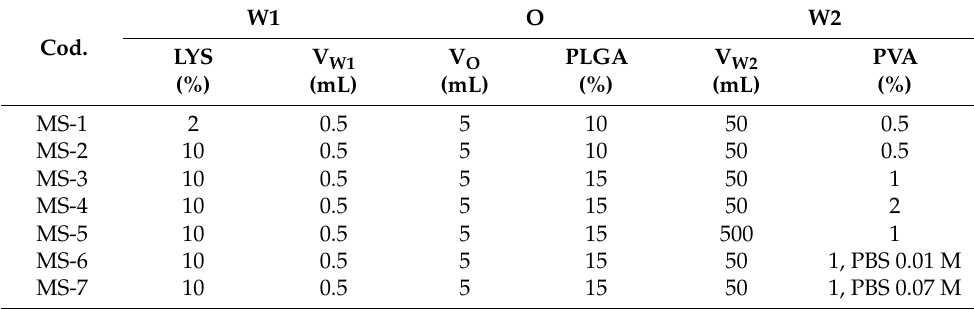
Table 1. Investigated processing parameters of